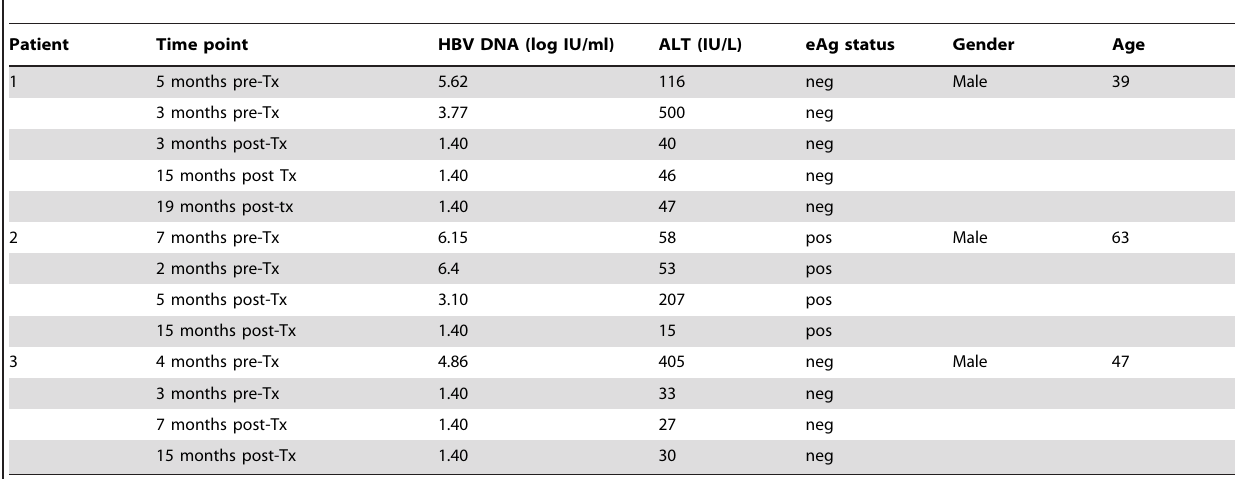
Table 3. Clinical characteristics of patients followed up longitudinally.